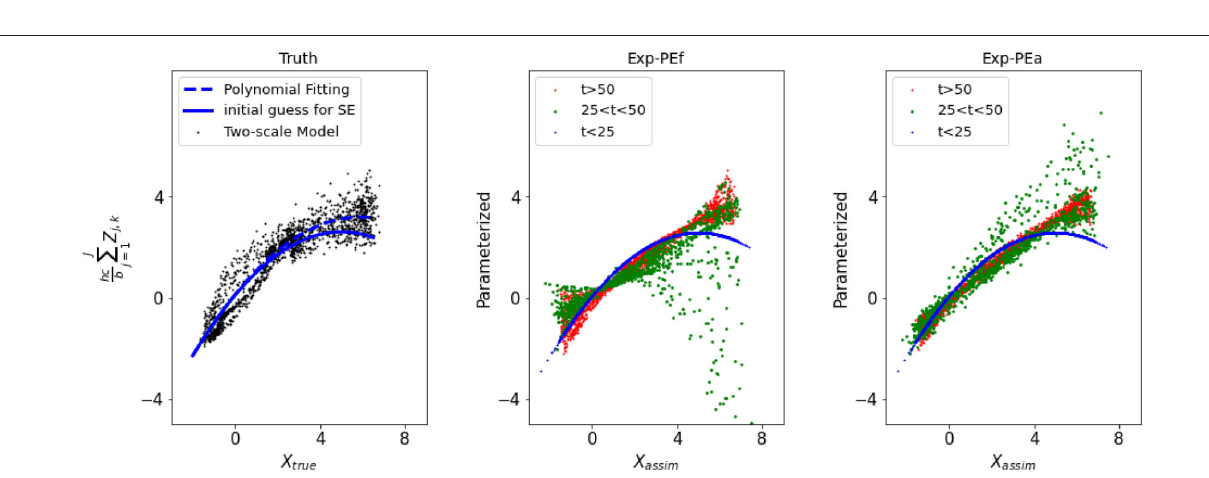
FIGURE 6 | Scatter plot of the effects of unresolved variables as a function of the resolved variable using true values (A) and the parameterization function values against the PE analysis with Exp-PEf (B) and Exp-PEa (C) .